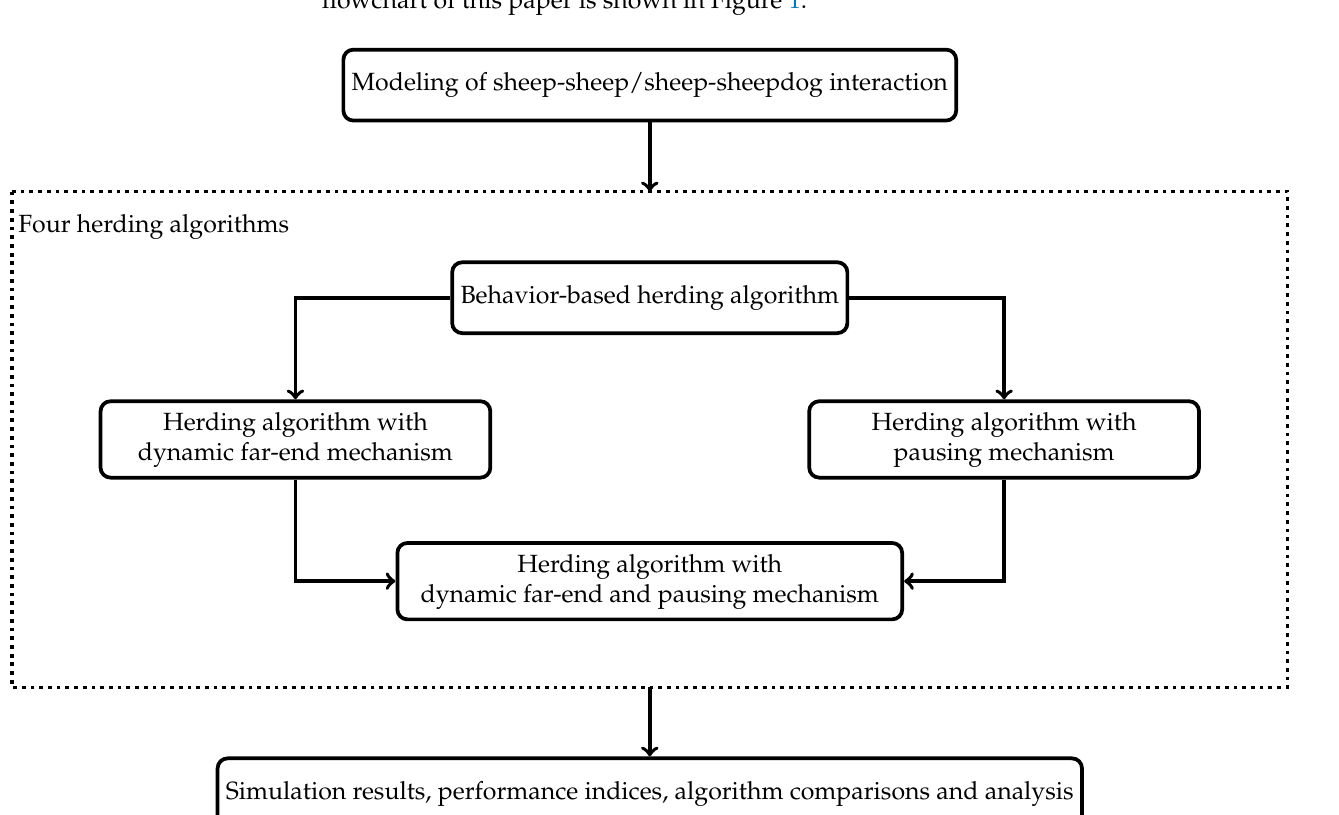
Figure 1. Research